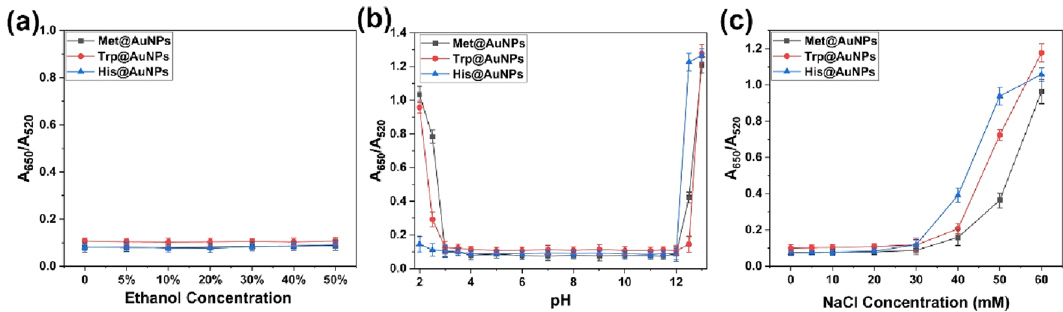
Figure 3. Effects of ( a ) ethanol concentration, ( b ) pH, and ( c ) NaCl concentration on the stability of AA@ AuNPs.